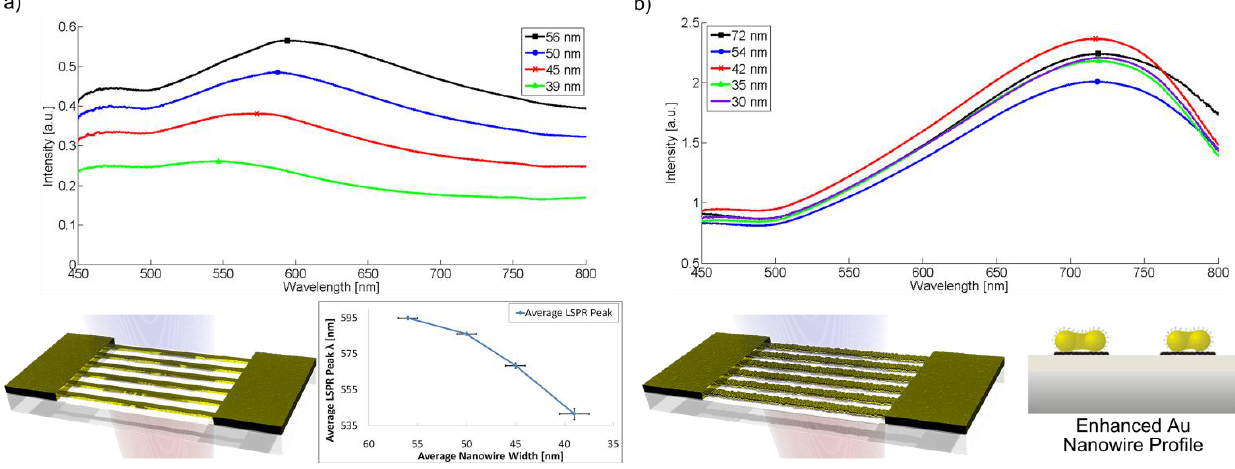
Figure 4. Optical extinction spectra of selected measureable chip regions with (a) evaporated Au and (b) 5 nm Au particle nanowires after chemical gold enhancement. The additional plot under the evaporated gold spectra shows the region-dependent LSPR peak of four different chips, thus demonstrating the spectral response dependence on nanowire width & separation for this system ( i.e. , at a constant 100 nm period for all